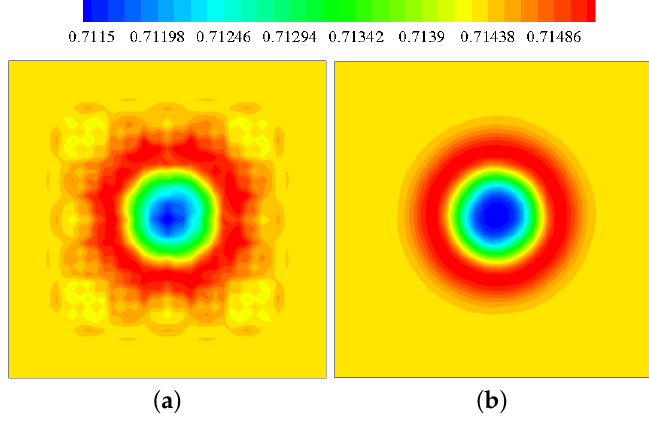
Figure 7. Instantaneous acoustic pressure at the central plane (2D x – y plane) of a 3D sound propagation showing the superior performance of the new metric evaluation procedure. ( a ) Standard metric formula; ( b ) New metric formula.